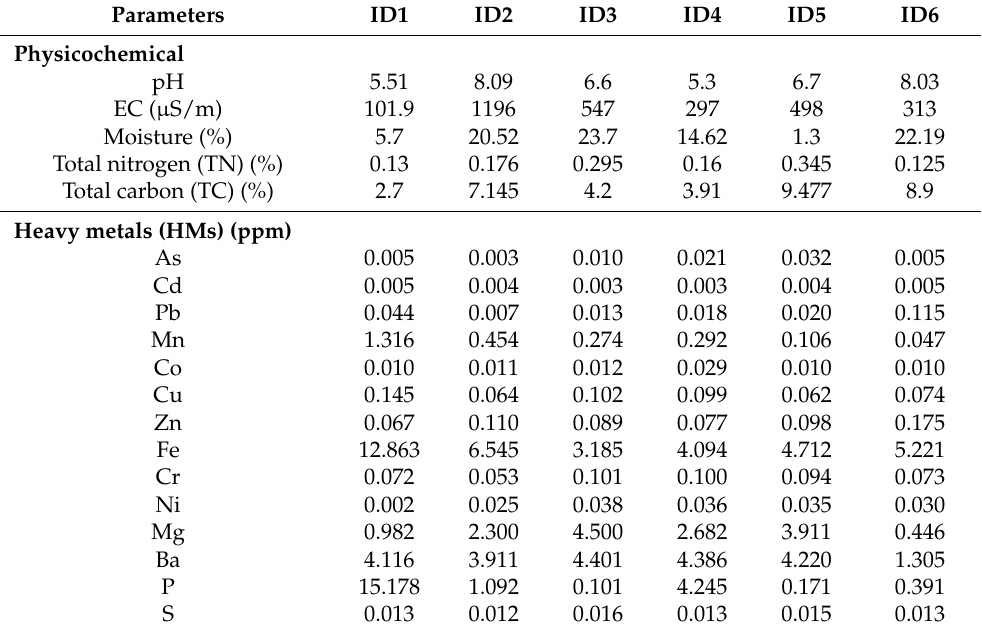
Table 1. Physicochemical parameters of the collected dumping site soil